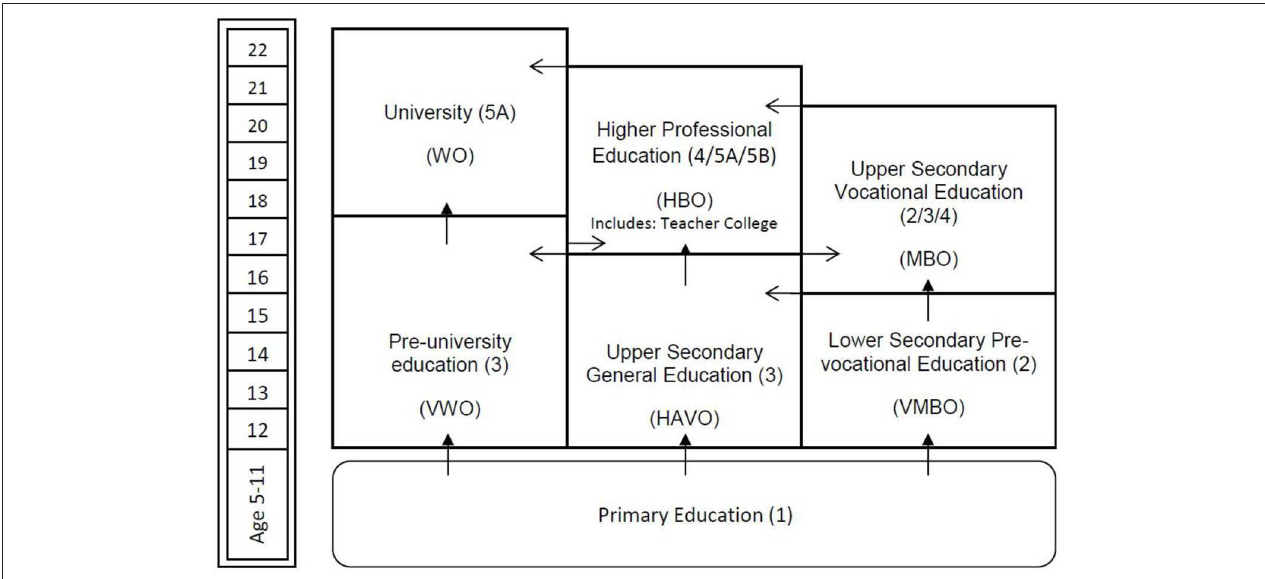
FIGURE 2 | The Dutch education system. After finishing primary education (grade 6), children are tracked into three educational levels based on the recommendation of the primary school. Prevocational Education (VMBO, 4 years), which prepares children for vocational education (3 or 4 years). The middle education level is referred to as upper secondary general education (HAVO, 5 years), which prepares children for higher professional education (HBO, 4 years). The highest education level children can be tracked to is referred to as pre-university education (VWO, 6 years), which prepares children for an academic university study (4 or 5 years). ISCED level in parentheses ( Cornelisz and van Klaveren,